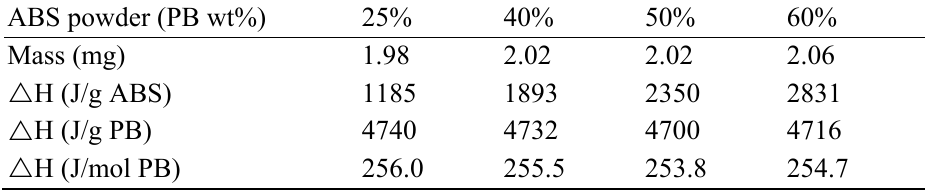
Table 3. Heat of auto-oxidation of ABS by 180  C isothermal